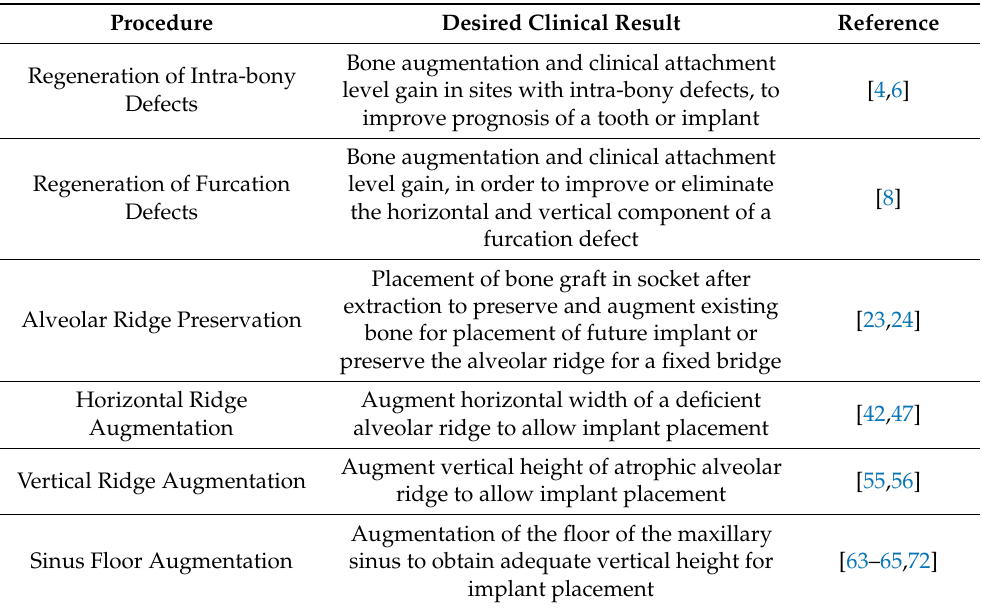
Table 3. The Importance of and procedures where biocompatible membranes are used in periodon- tal/oral surgery regenerative